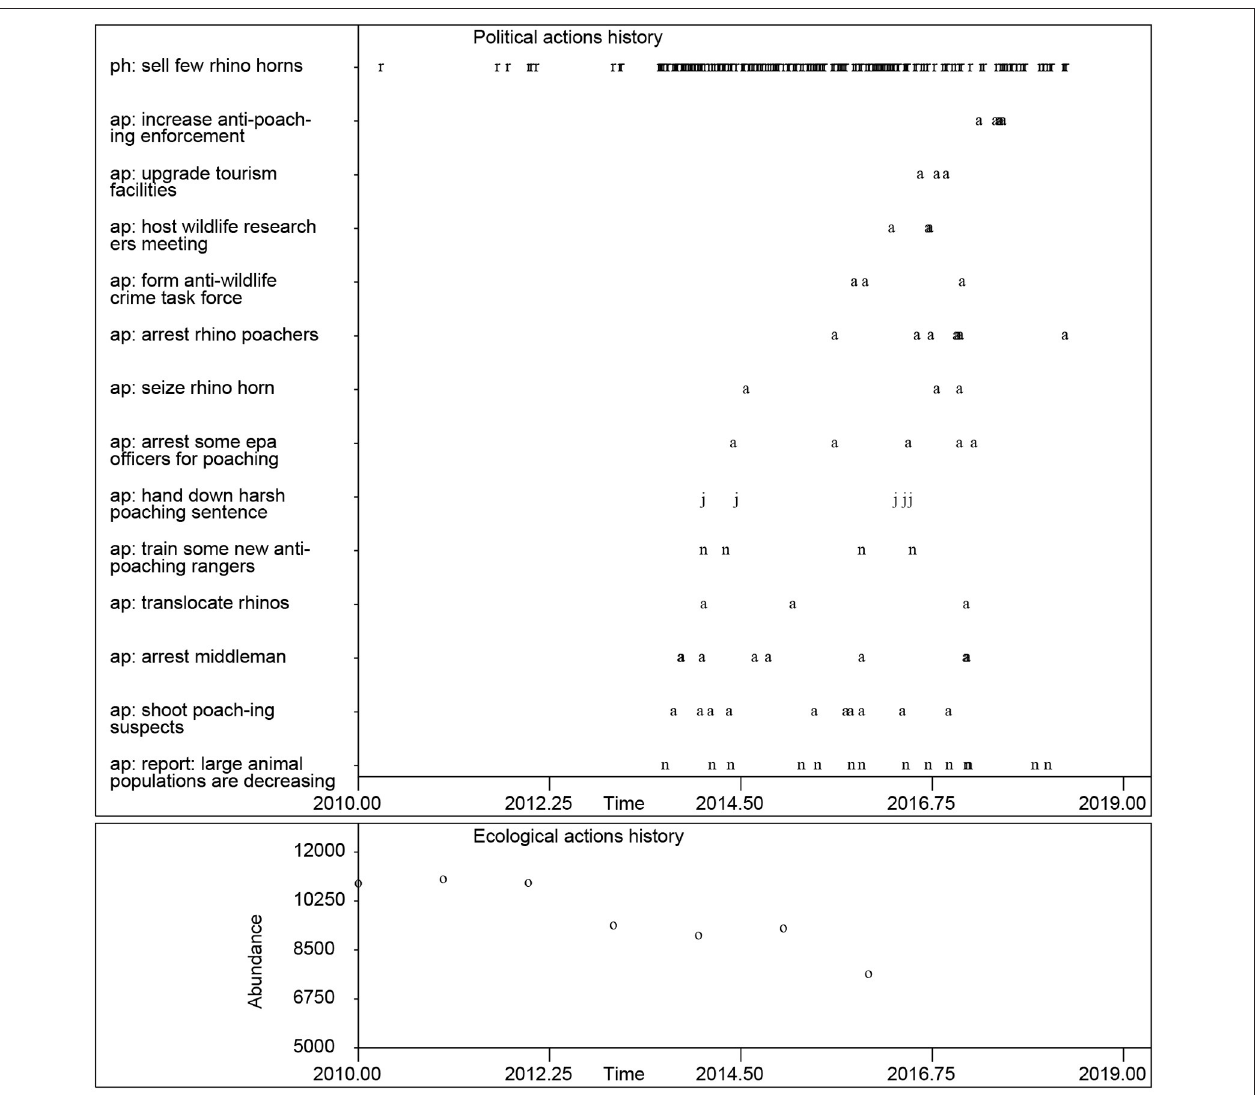
FIGURE 5 | Observed actions history from South African online news stories for the period January 2010–June 2019. Rhino poachers are designated by ph . South African rangers and administrators engaged in anti-poaching activities are designated by ap . Rhino abundance data is from Haas and Ferreira (2018). See Figure 4 for the plotting symbol